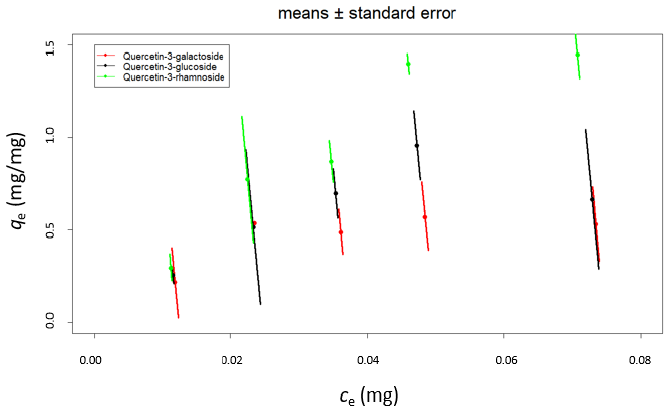
Figure 1. Adsorption of quercetin derivatives onto β -glucan.